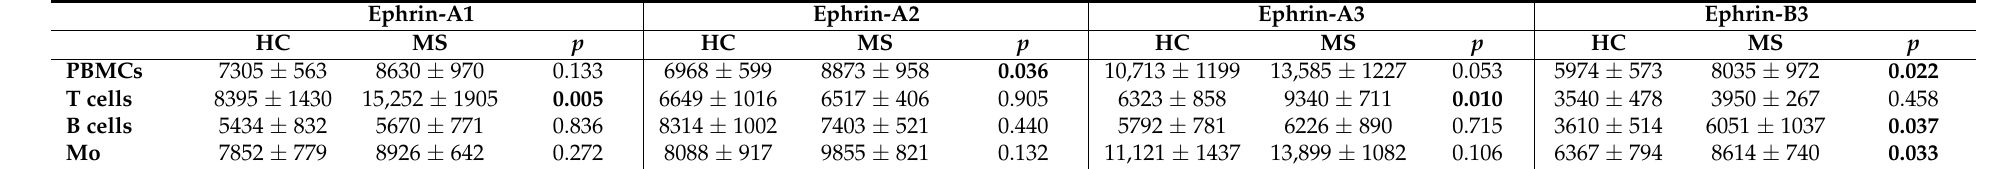
Table 2. Ephrin means fluorescence intensity on different immune